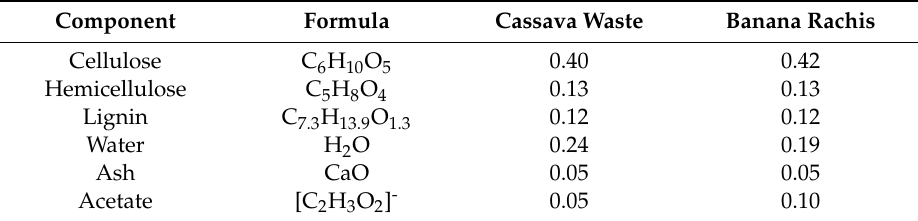
Table 1. Chemical composition of lignocellulosic